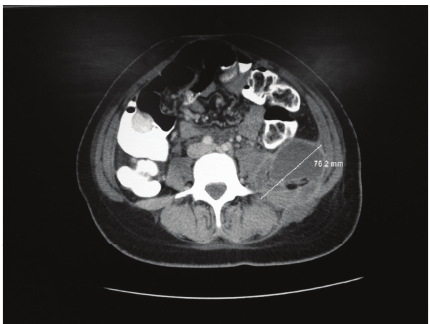
Figure 1: CT of abdomen/pelvic revealing a 7.6 × 5 cm left colonic abscess.